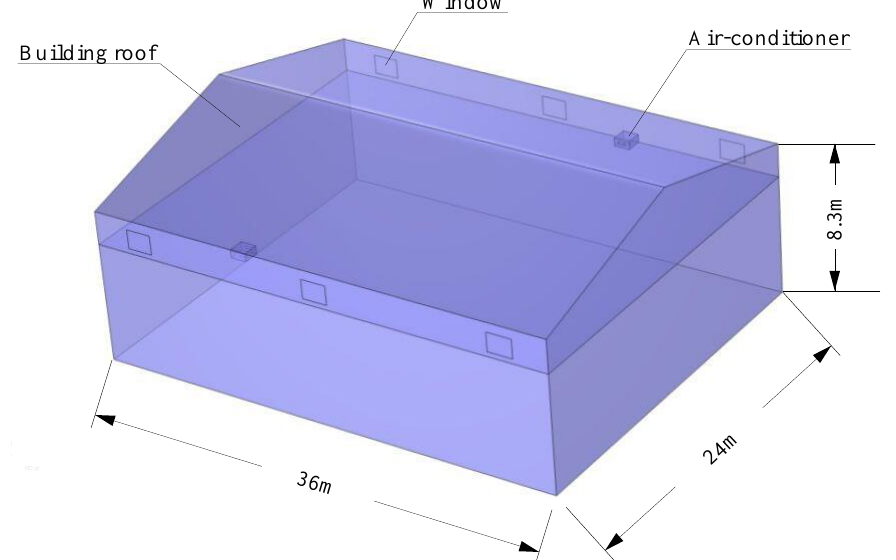
Figure 5. COMSOL model of the low-temperature granary.